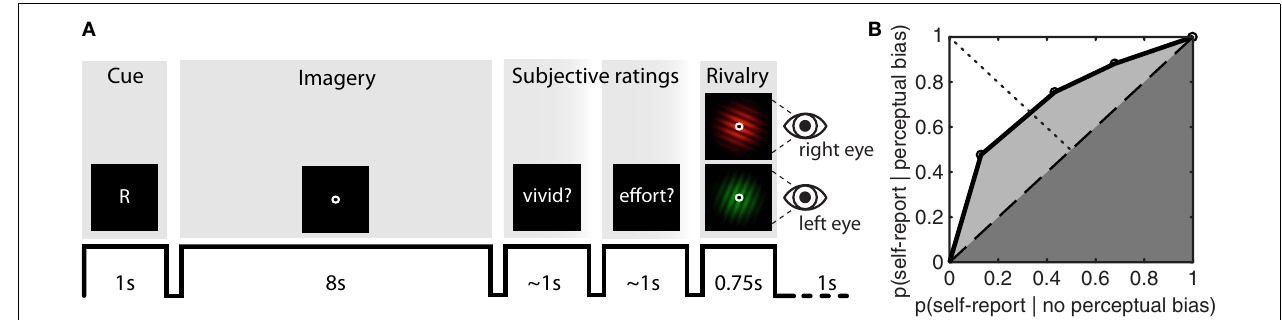
of the two. On 10% of the trials – instead of the rivalry display – a mock-stimulus was presented to both eyes simultaneously, consisting of a physical combination of both the green and red grating. (B) To determine how well subjective ratings predict perceptual bias, type II ROC sensitivity was calculated by taking the area under the ROC curve ( A roc ).This area is the sum of the area of the half-square triangle (dark-gray shaded region) and the area between the diagonal and the ROC function (light-gray shaded